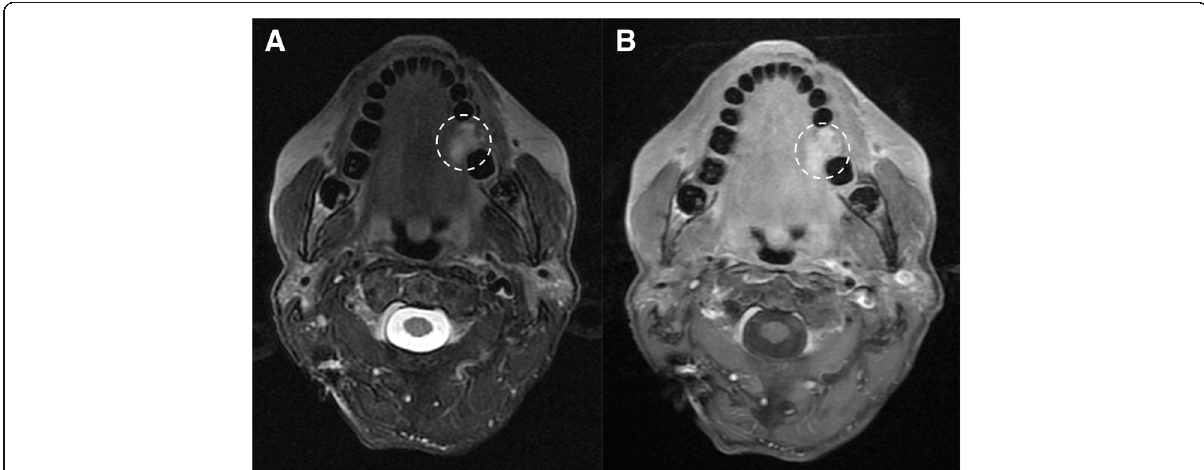
Fig. 15 Neurofibroma of the lingual nerve. Patient with NF1. MRI T2-weighted fat-suppressed ( a ) and T1-weighted post-gadolinium ( b ) axial images, display an hyperintense and enhanced round mass along the course of the left lingual nerve (dotted